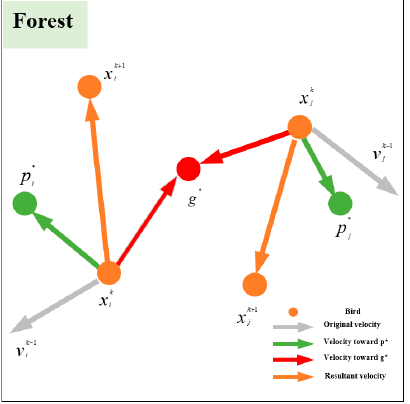
Figure 4. The schematic of the optimization process of PSO.